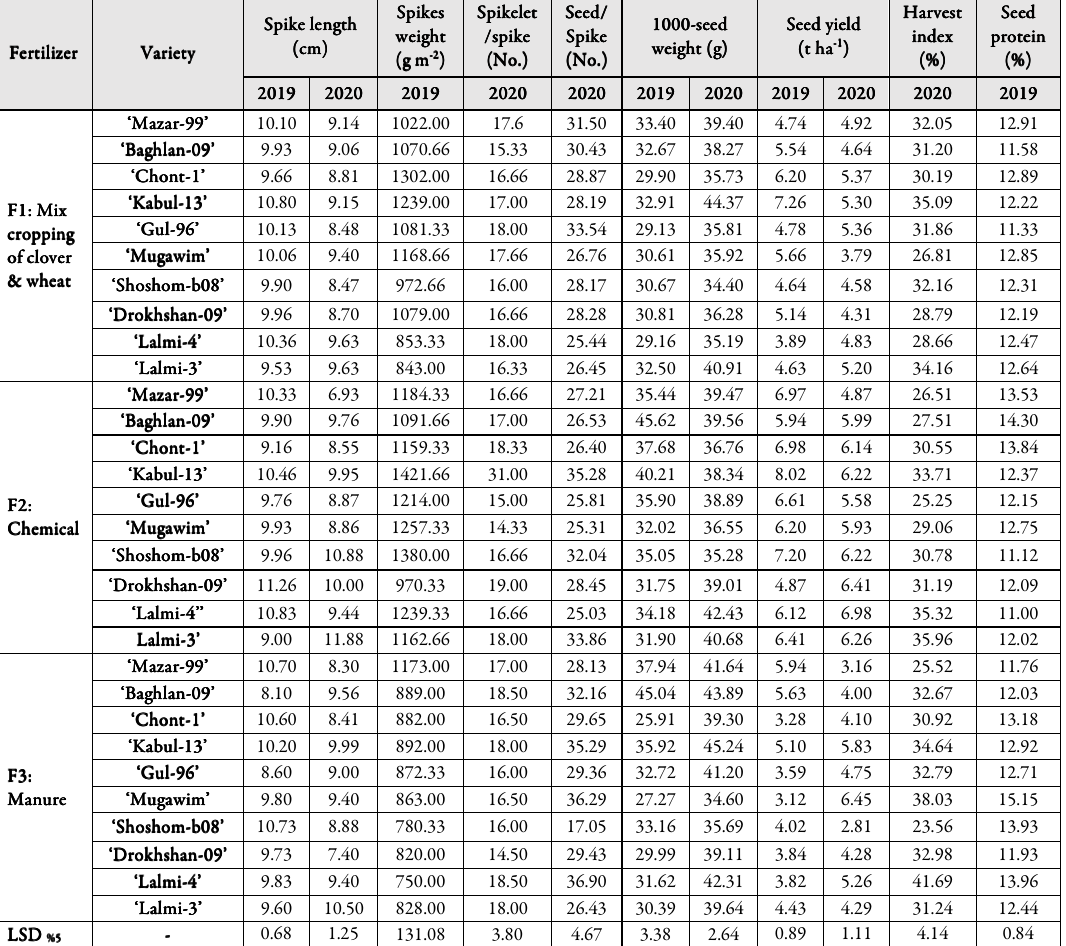
Table 4. Interaction effect of fertilization and variety on some vegetative and reproductive parameters of